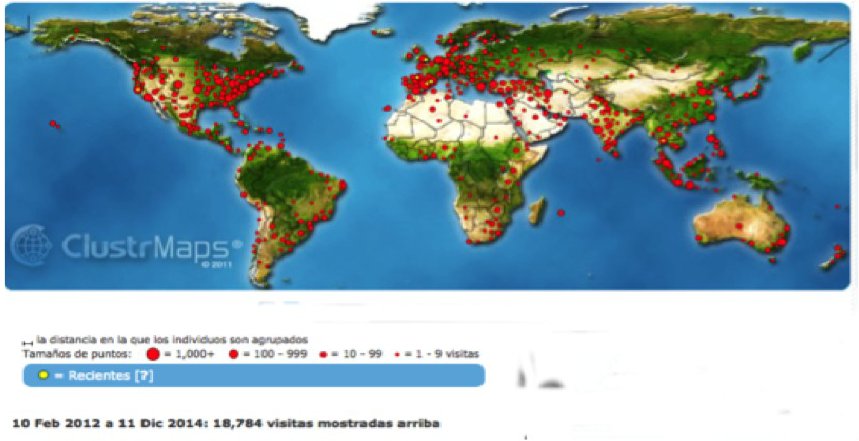
Figure 1. JOTSE readers/visitors from January 2012 to December